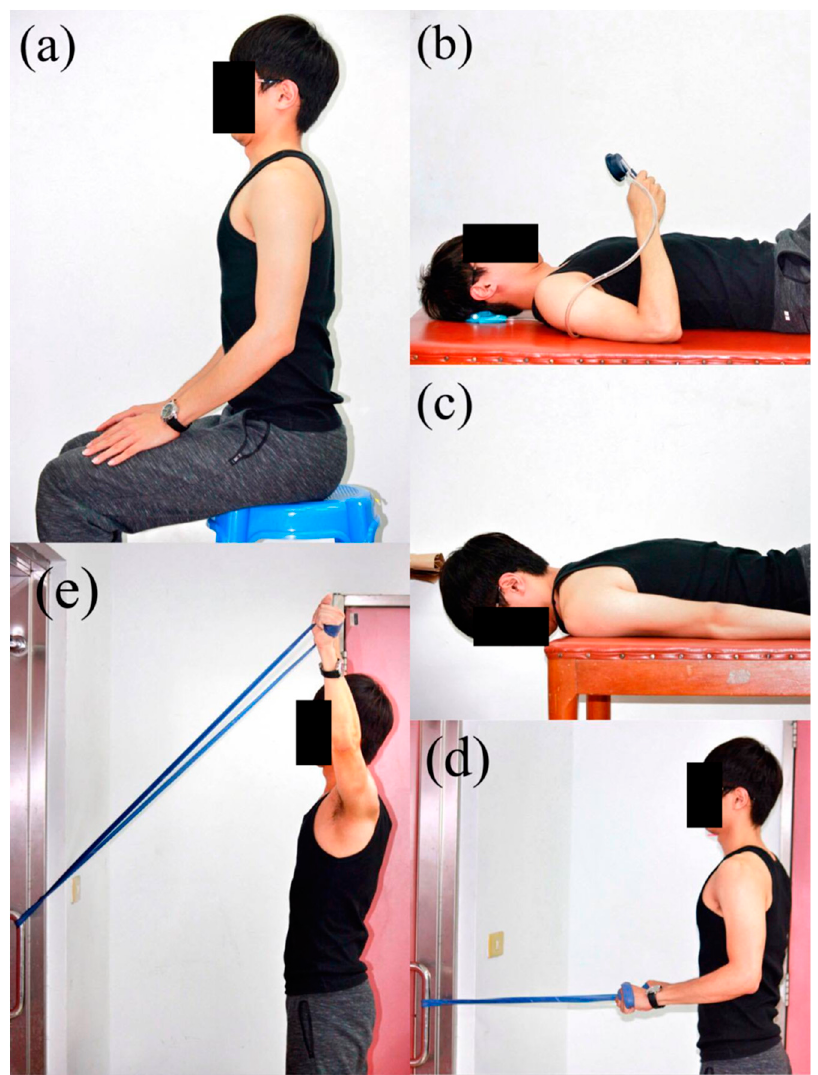
Figure 2. Six-week video-based exercises: ( a ) axial elongation exercise, ( b ) craniocervical flexion exercise, ( c ) craniocervical extension exercise, ( d ) rowing exercise, ( e ) Y exercise.